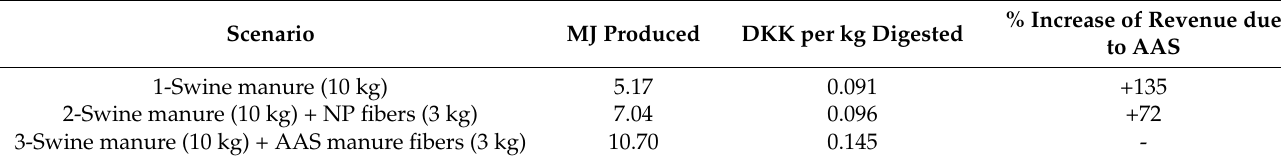
Table 6. Energy output and revenue for different scenarios.